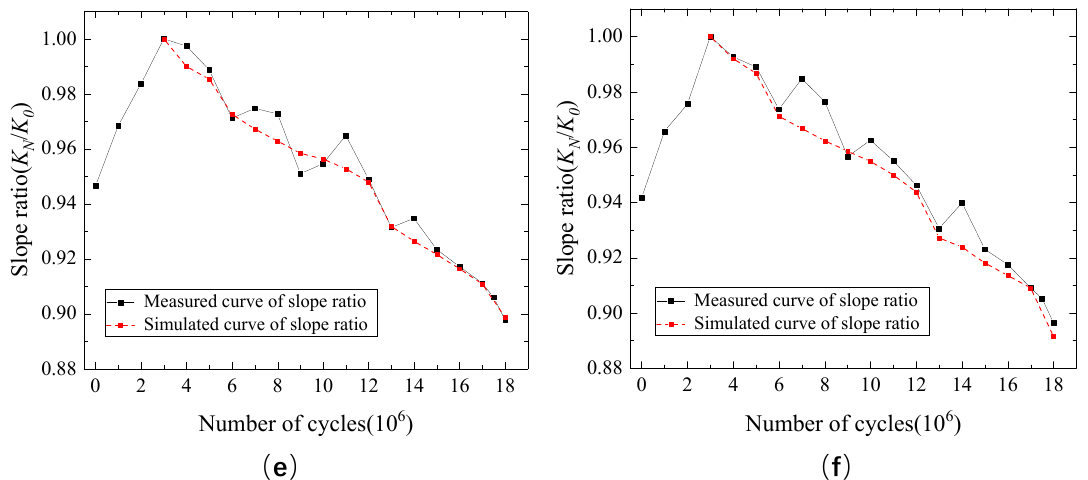
Figure 12. Comparative analysis of finite element results and experimental results: ( a ) Load–strain curve of L/2 section; ( b ) Load–strain curve of L/4 section; ( c ) Slope change curve of L/2 section; ( d ) Slope change curve of L/4 section; ( e ) Slope ratio curve of L/2 section; ( f ) Slope ratio curve of L/4 section.